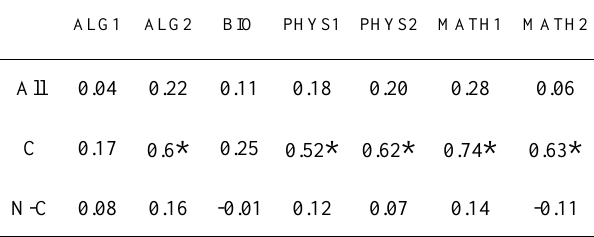
The Pearson’s correlation coefficient for the Blink Count parameter and the evaluation of the task difficulty level for the particular tasks.